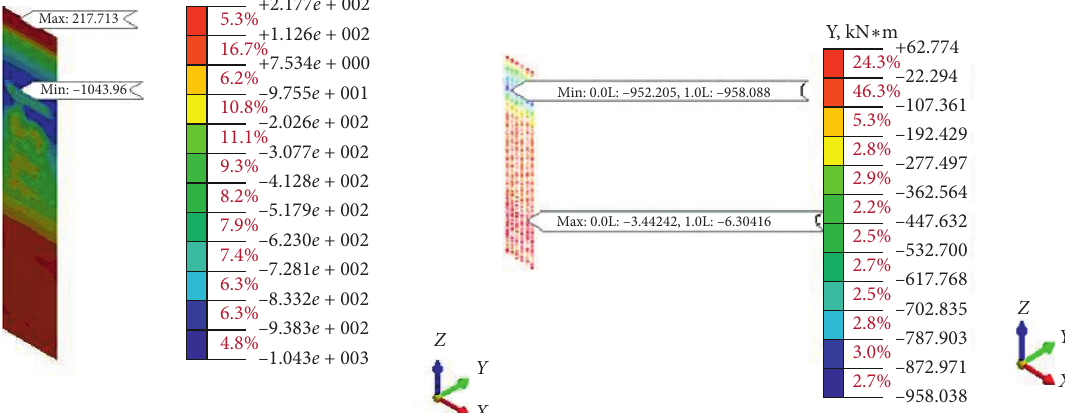
Figure 18: Afterbackfillingofwharf,thebendingmomentpermeterofthefoundationpitexcavationtotheendofsupportingstructure(unit:kN · m).